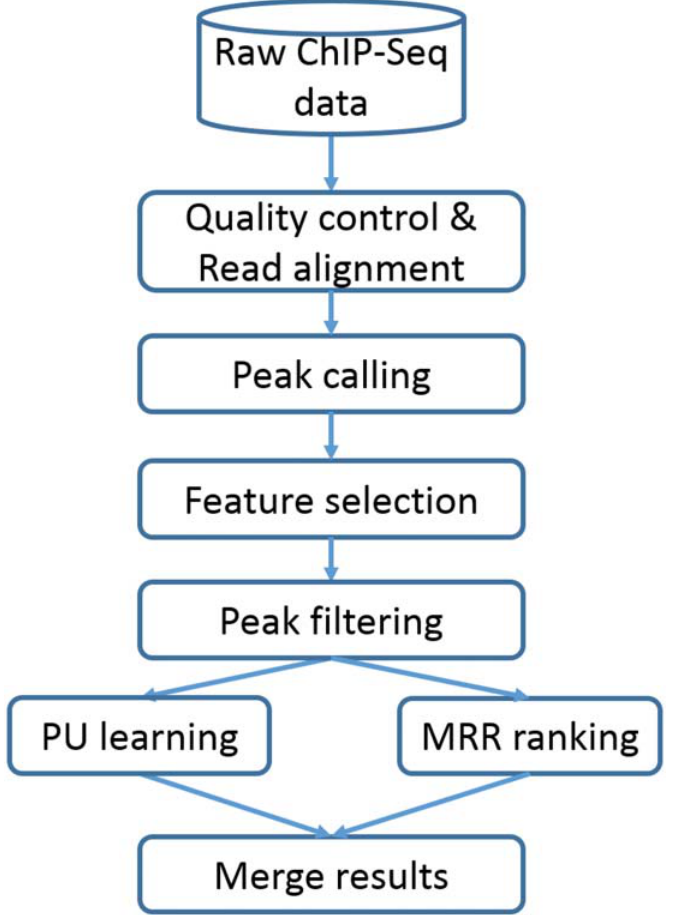
Fig 1. The flowchart of the pipeline. The raw ChIP-Seq data is first preprocessed by filtering low quality reads and aligned to the reference genome. Then peak calling tool is utilized to identify peaks from the alignment. In the next step, multiple features are derived for each candidate peak. The step of peak filtering keeps one peak for one miRNA using the derived features. And then PU learning and MRR ranking are employed and their results are merged to get the final